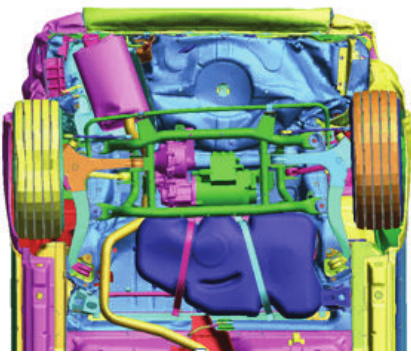
Figure 2: The rear-end collision simulation of E-REV.